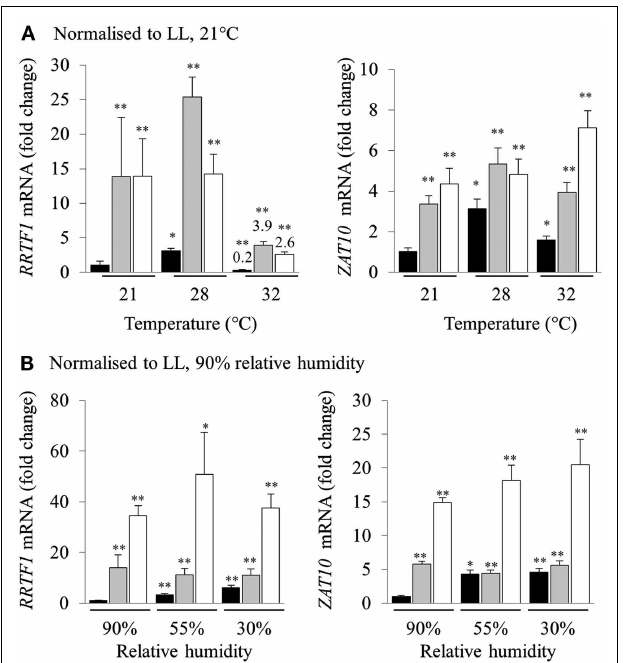
FIGURE 3 |Analysis of RRTF1 and ZAT10 transcripts under 21, 28, and 32˚C and 90, 55, and 30% relative humidity during HL SAA. LL control (black), HL (white), and distal (grey). In (A) the data are normalized to LL 21˚C, for each sample, for (B) the data are normalized to LL 90% relative humidity, for each sample n = 6, * p < 0.005, ** p < 0.001, n.s., not significant, error bars indicate standard error. LSD post hoc tests from one-way ANOVAs show that for both RRTF1 and ZAT10 plants under 55 and 30% humidity LED treatments the differences between LL and DL tissues is not statistically significant ( P > 0.05).